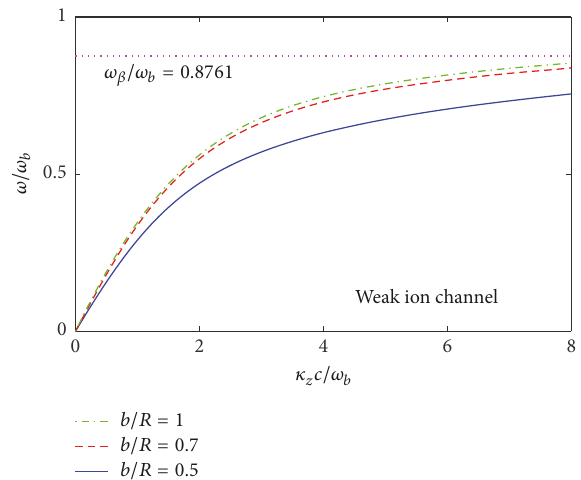
Figure 7: The effect of the ratio 𝑎/𝑏 on the dispersion curves of the Be 01 waves for weak ion channel with 𝜔 𝛽 = 0.8761 . The outer radius of the annular beam is taken as 0.5 R and 𝑎/𝑏 = 0 represents the solid beam case.